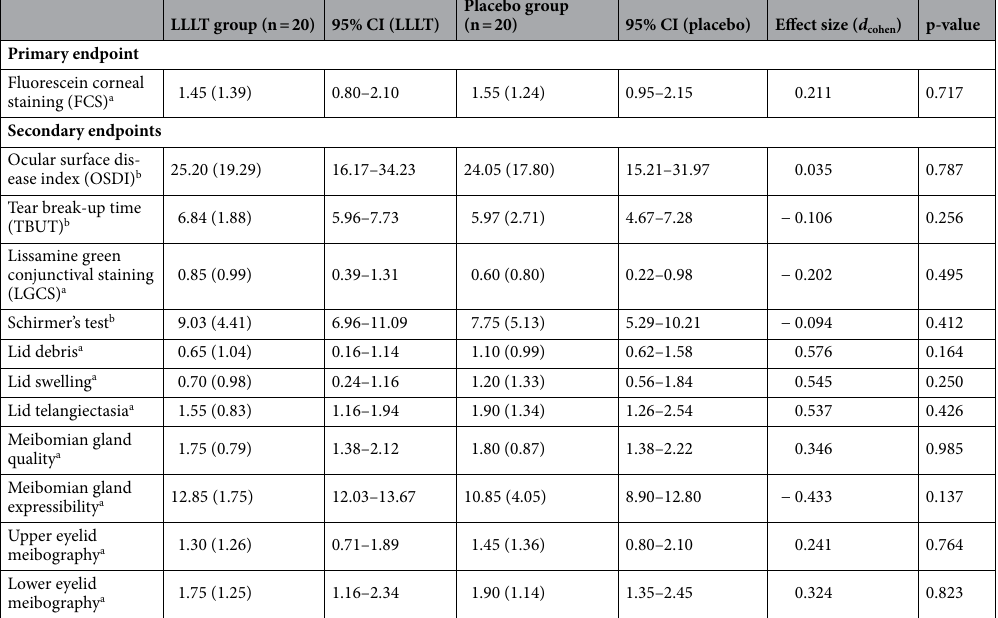
Table 2. Intention-to-treat analysis for the primary and secondary endpoints after LLLT interventions. a Wilcoxon rank sum test results. b Independent sample t-test.